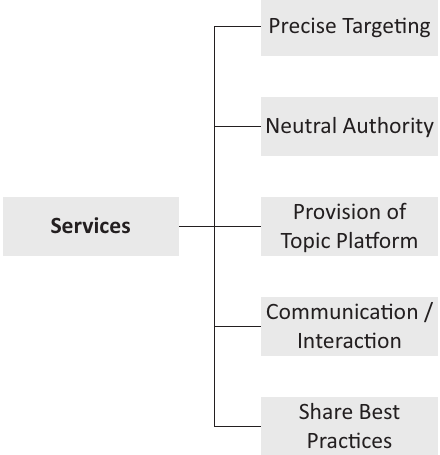
Figure 6. Advertisers’ expectations towards further ser- vices of